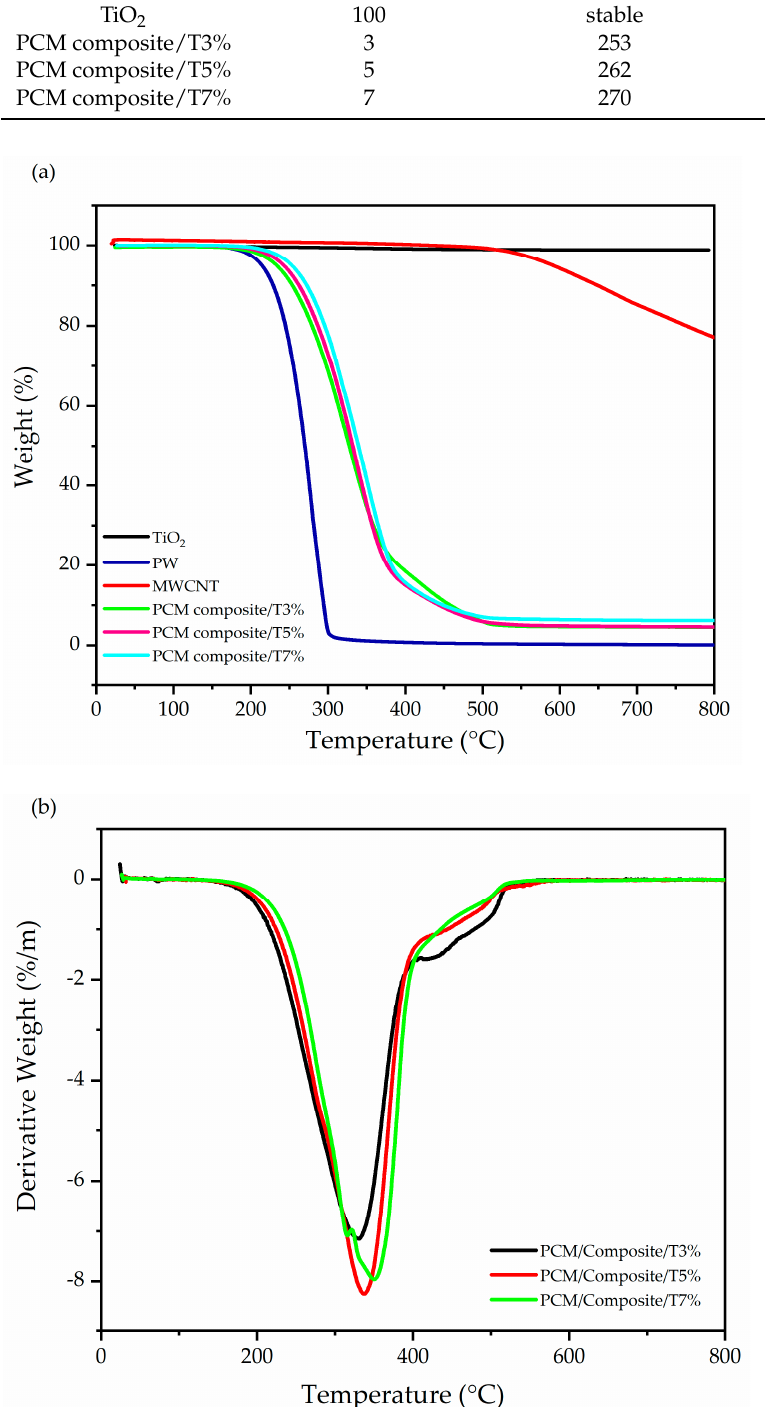
Figure 4. ( a ) Thermogravimetric analyzer (TGA) plot of the composites ( b ) derivative thermogravimetry curves of PCM composites.